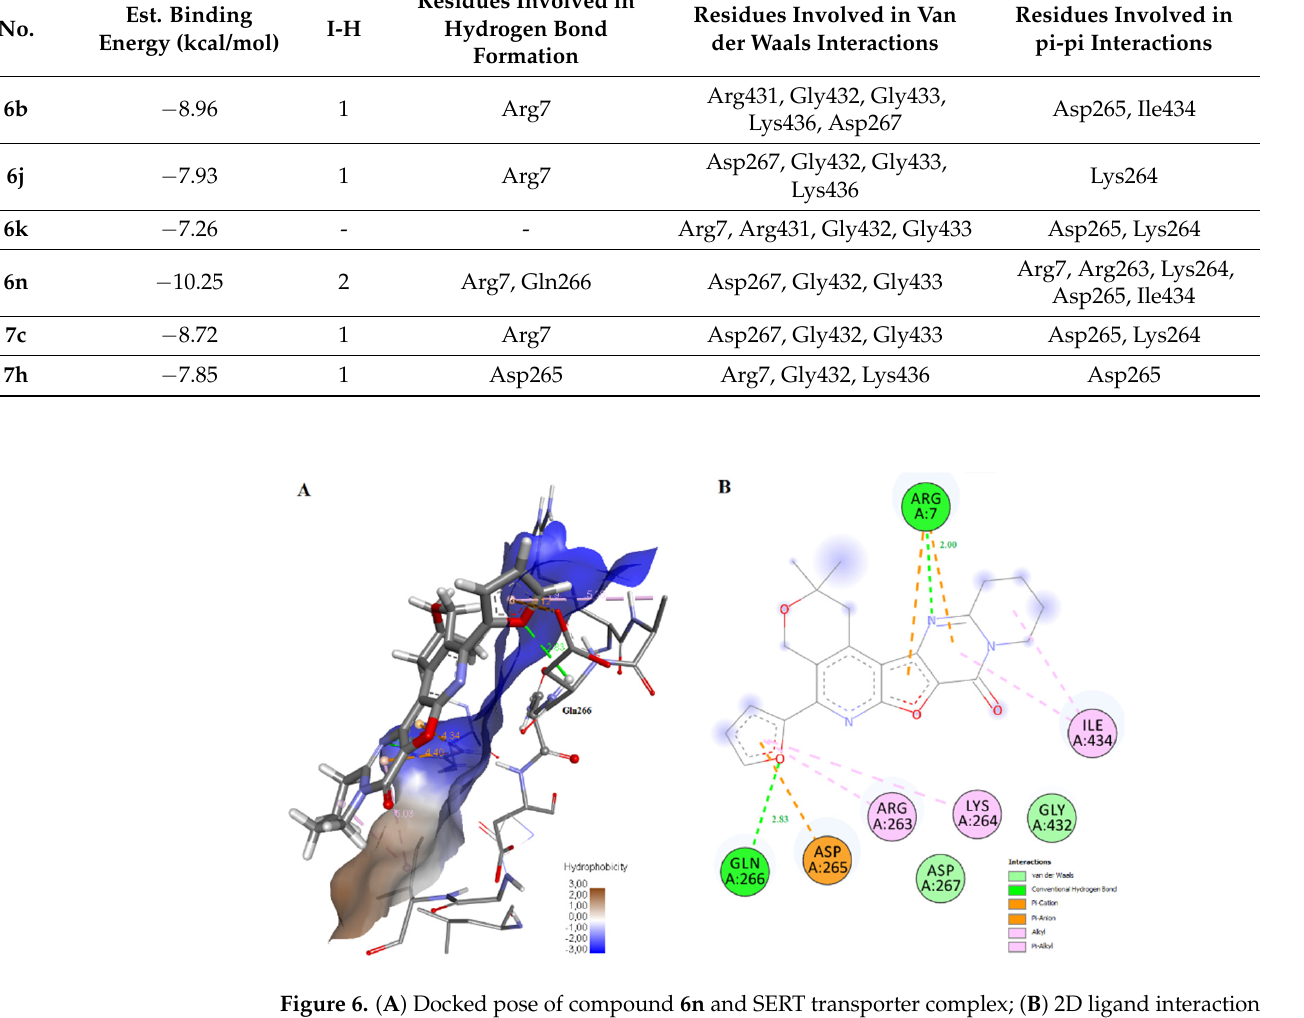
Table 9. Molecular docking free binding energies (kcal/mol) in 5-HT 1A receptor (PDB ID: 3NYA). No.